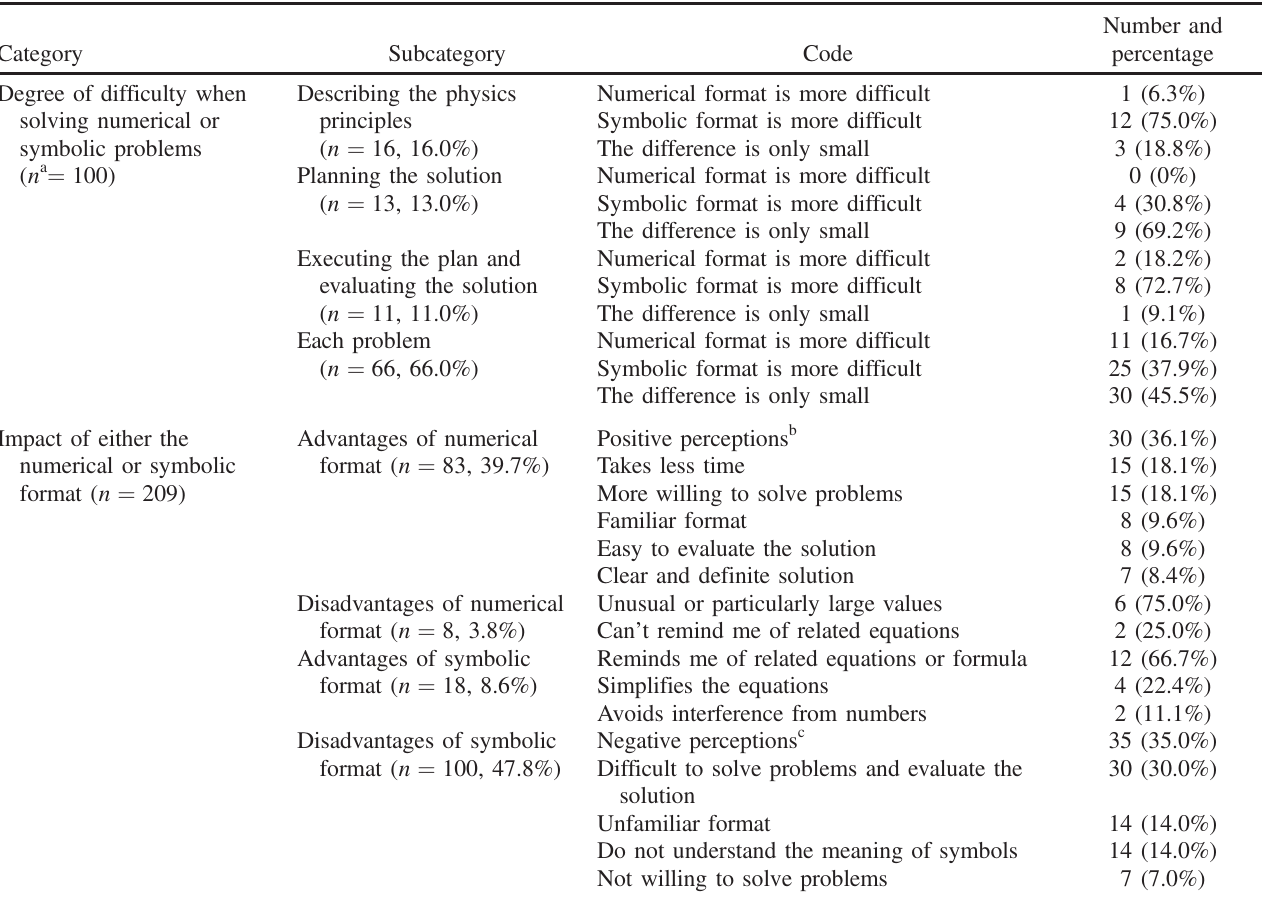
TABLE VII. Coding scheme and results of the interview transcripts. Category Degree of difficulty